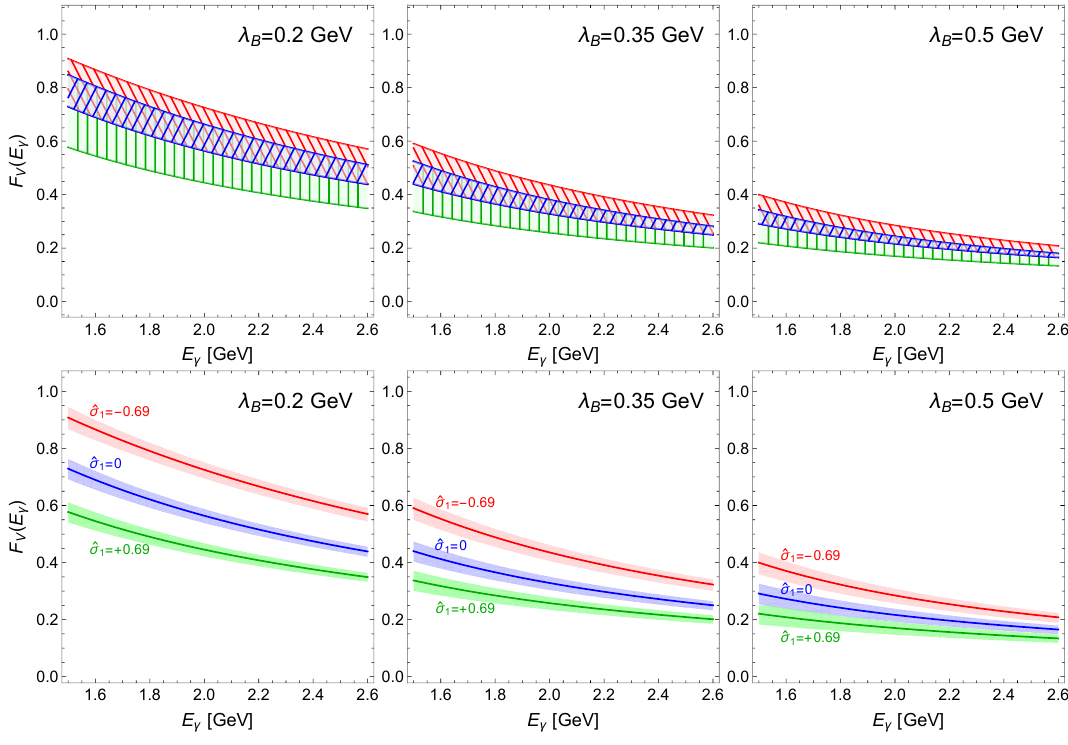
Figure 7 . Vector form factor F V ( E (cid:13) ). The shaded regions on the upper panels show the variation for a given model with the range of parameters speci(cid:12)ed in (5.3). The uncertainty due to other parameters in the range speci(cid:12)ed in table 1 is shown on the three lower panels for sponding to the boundary of the models’ envelope in the upper plot, and for to the simple exponential ansatz [4]. The colour coding corresponds to (cid:12)gure 3.